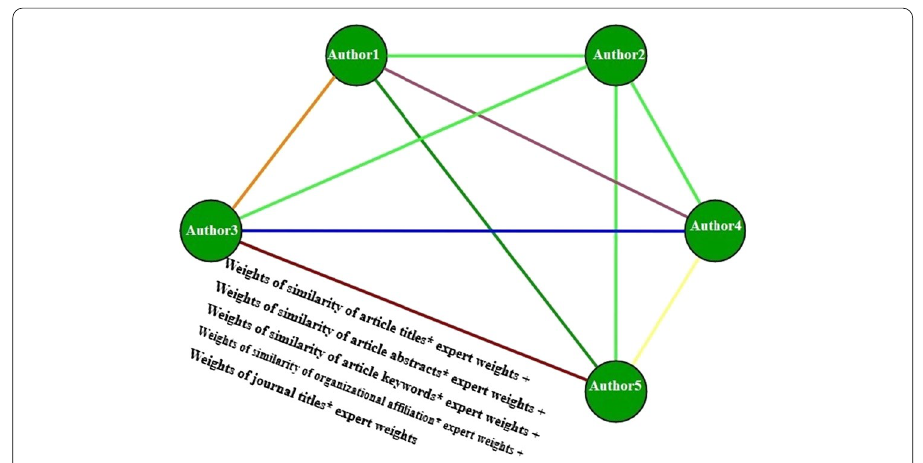
Fig. 4 The complete graph among the criteria